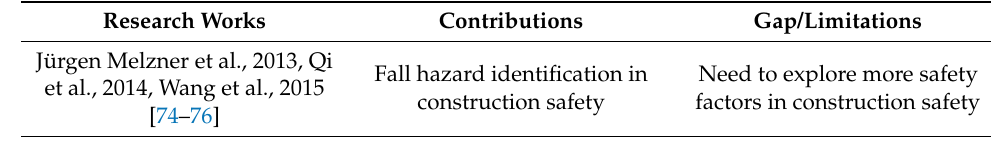
Table 2. Summary of the rationale and research